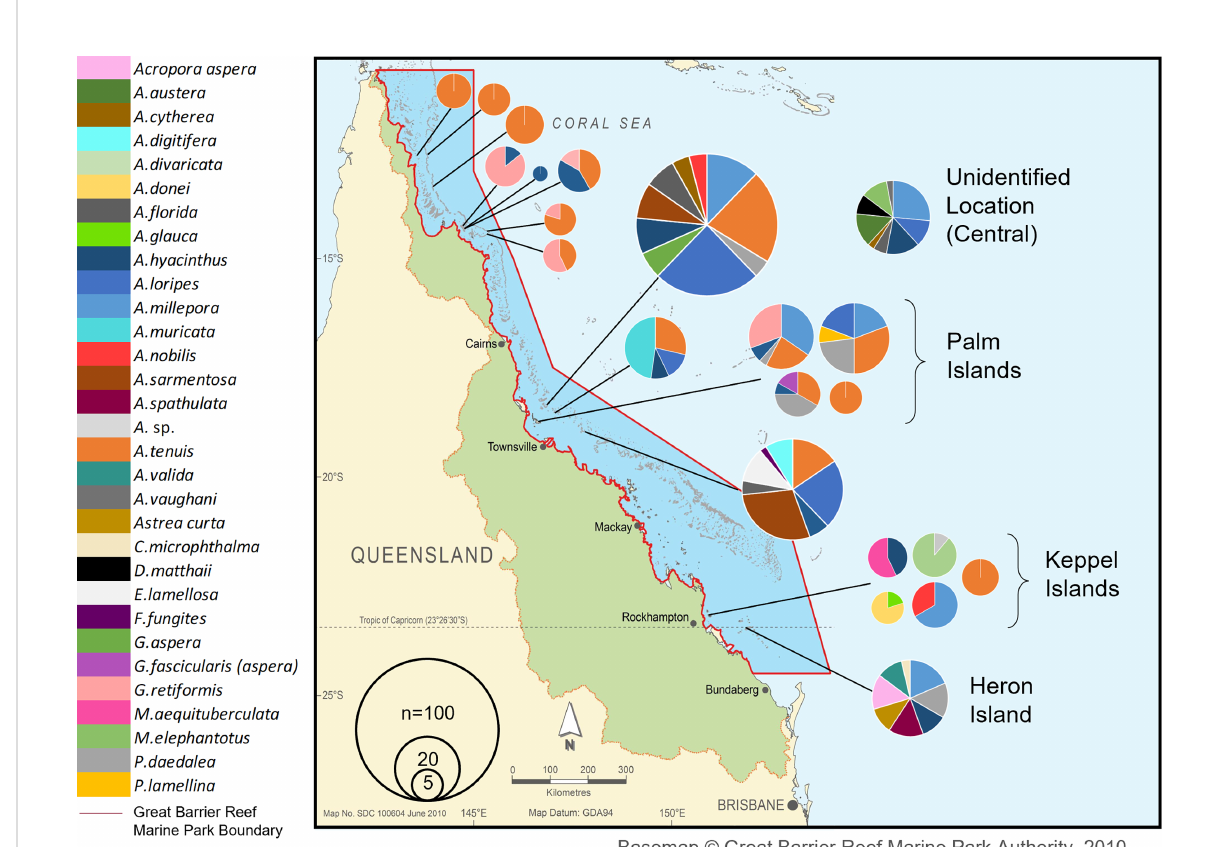
FIGURE 3 Species represented within Taronga ’ s CryoDiversity Bank mapped by reef location sampled. The 22 reefs sampled (starting top left to right and down) were: North MA: Curd, Long Sandy, Sand Bank No.7, South Warden, Munro, Switzer, Jewell, Parke; Central MA: Trunk, Backnumbers, Palm Islands (Falcon, Esk, West Pelorus, Mundy), Davies; and South MA: Keppel Islands (Humpy, Great Keppel, Outer Rocks, Pleasant (Conical) Island, Halfway Island), Heron Island. The size of each circle represents the total number of coral colonies collected from the location; each slice represents the proportion of colonies sampled by species. See Table 1 for full species